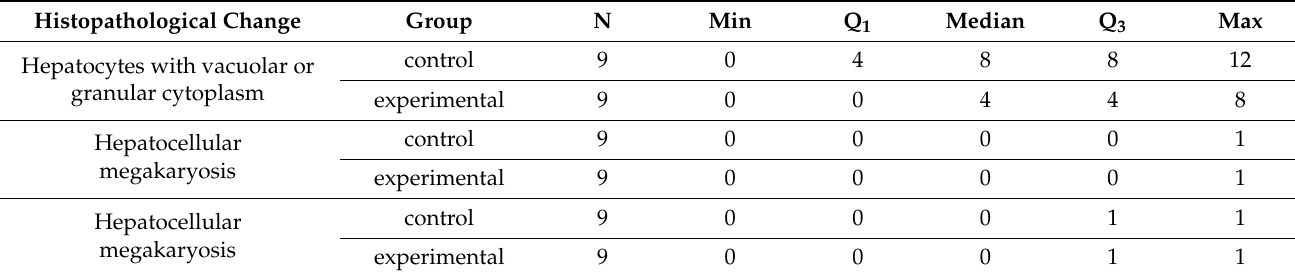
Table 2. The final scores for each histopathological change in the liver of control and experimental piglets presented with basic descriptive